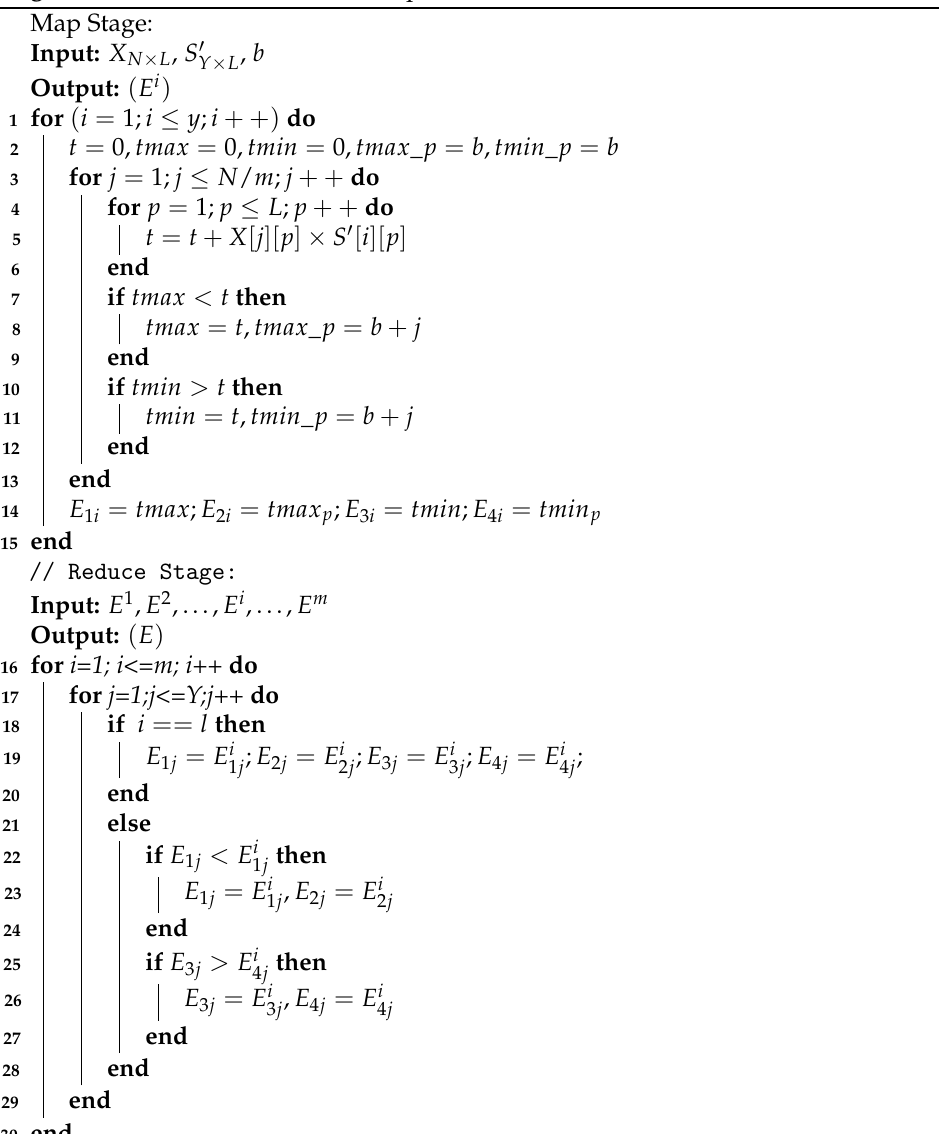
Algorithm 1: Parallel PPI Based on